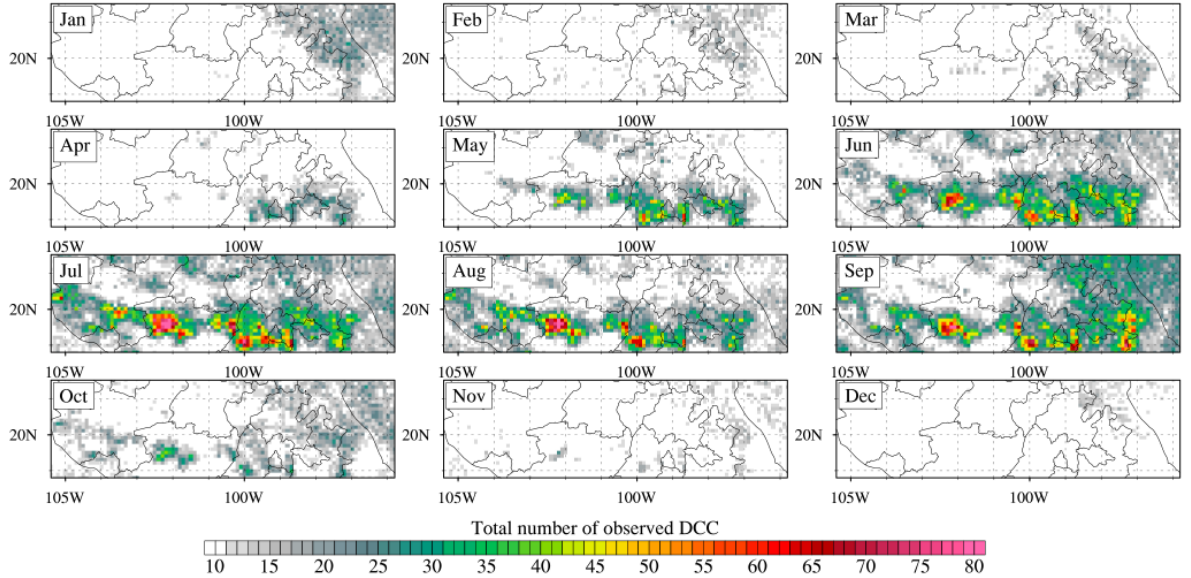
Figure 3. Monthly distribution of the total number of observed deep convective clouds based on MODIS cloud data (2008–2017) with a horizontal resolution of 0.1